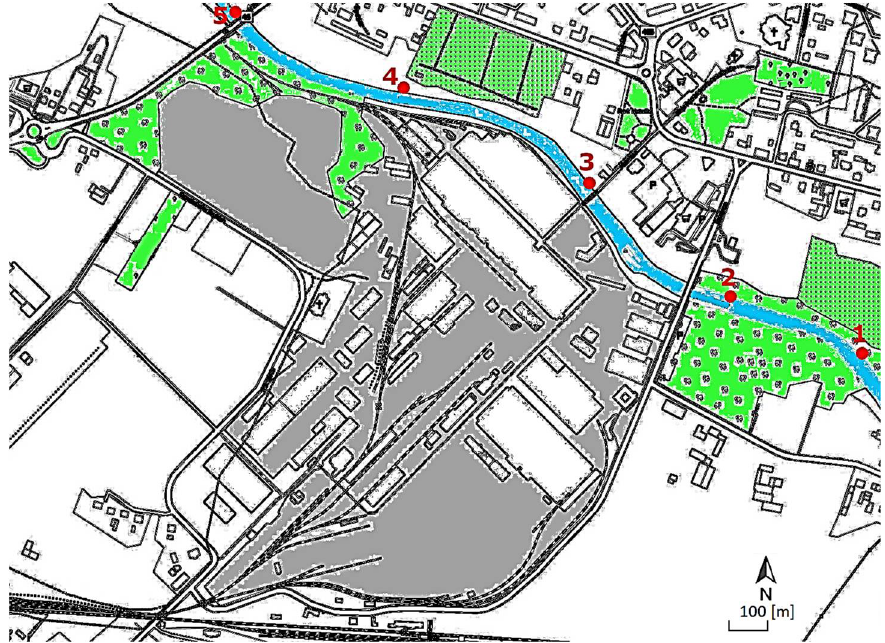
Figure 1. Exposure sites of moss and algae samples; red color indicates measurement points; green color symbolizes green areas, parks, forests, etc., gray color indicates the area around the smelter.